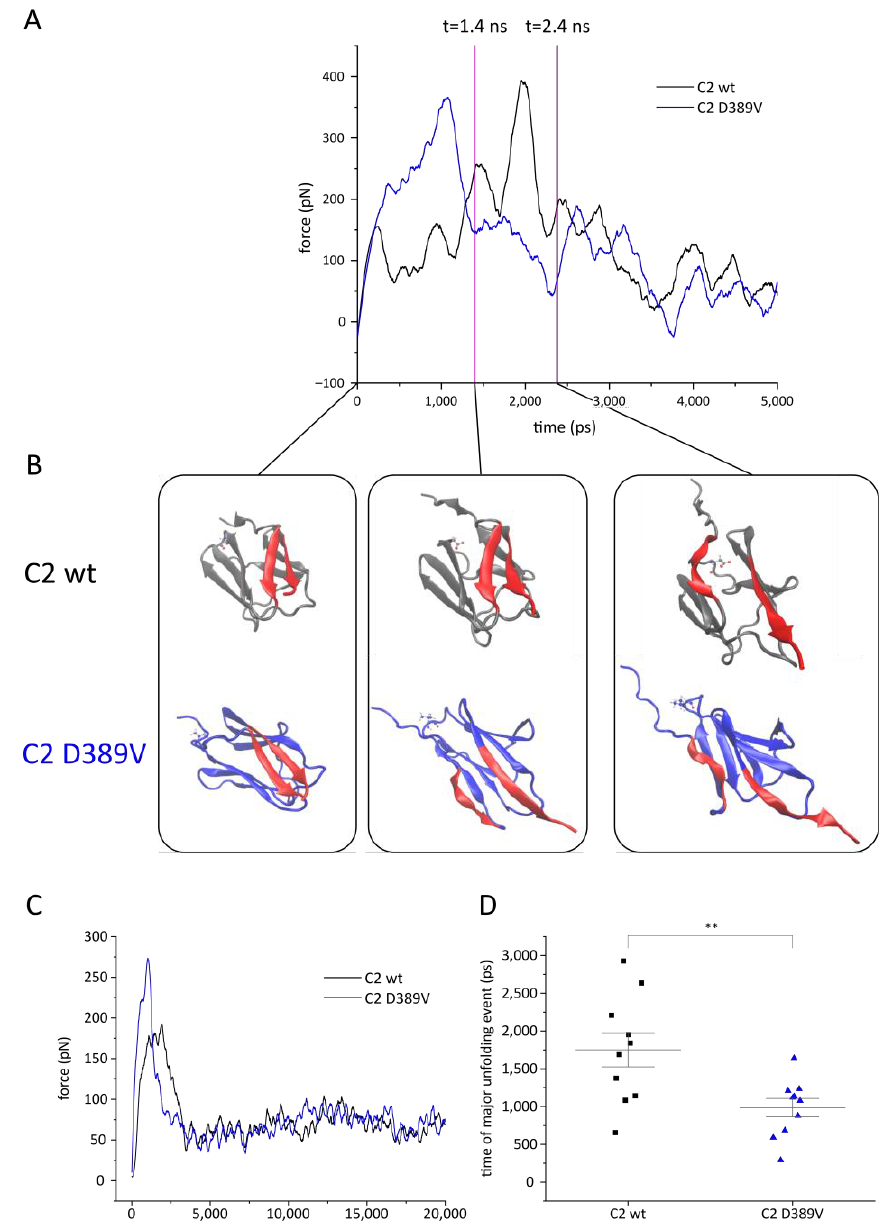
Figure 6. Constant velocity steered molecular dynamics (cvSMD) simulation of MyBPC C2 domain unfolding. The SMD atom P452Cα was pulled at a velocity of 0.01 Å /ps and the spring constant was set to 7 kcal/mol/Å. ( A ) Sample traces for an unfolding simulation of each wt and D389V MyBPC C2 domain. The force acting on the SMD atom is plotted against the time of the simulation. Data were smoothened using Savitzky–Golay filter to compensate for the noise created by the spring acting on the fixed atom. ( B ) Sample structures of time points 0, 1400, and 2400 ps in the unfolding experiments displayed in ( A ). C2 wt and C2 D389V are shown in grey and blue, respectively, with residue 389 as a CPK model. Residues A372–K377 and T445–P452 of the parallel β 1–6 strands are marked in red. ( C ) Average of n = 10 independent unfolding simulations of each wt and D389V MyBPC C2 domain. The force acting on the SMD atom is plotted against the time of the simulation. Data were smoothened using Savitzky–Golay filter to compensate for the noise created by the spring acting on the fixed atom. ( D ) The time point of the major unfolding event is plotted for each individual unfolding experiment. The major unfolding event is defined as the global maximum of the force–time curve. The peak of unfolding occurred on average after 1751 ± 714 ps for wt and 986 ± 384 ps for D389V. ** p < 0.01.